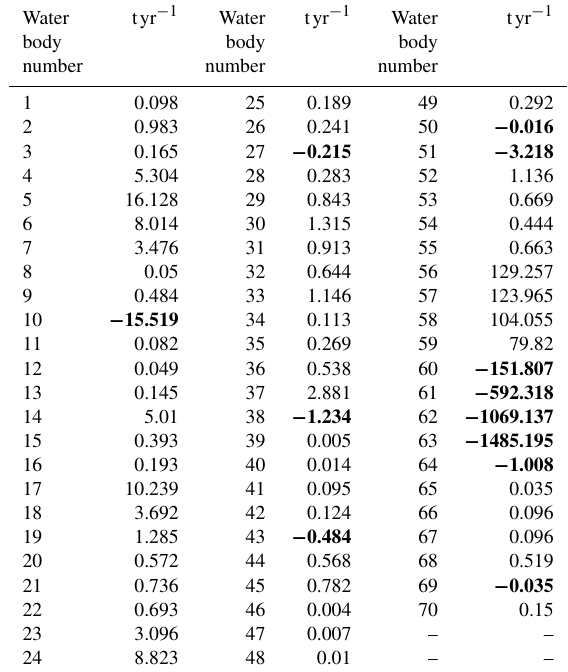
Table 6. Total nitrogen absorption capacity for each profile of Mid- dle Warta water bodies based on characteristic flow SNQ. The neg- ative values are in boldface.